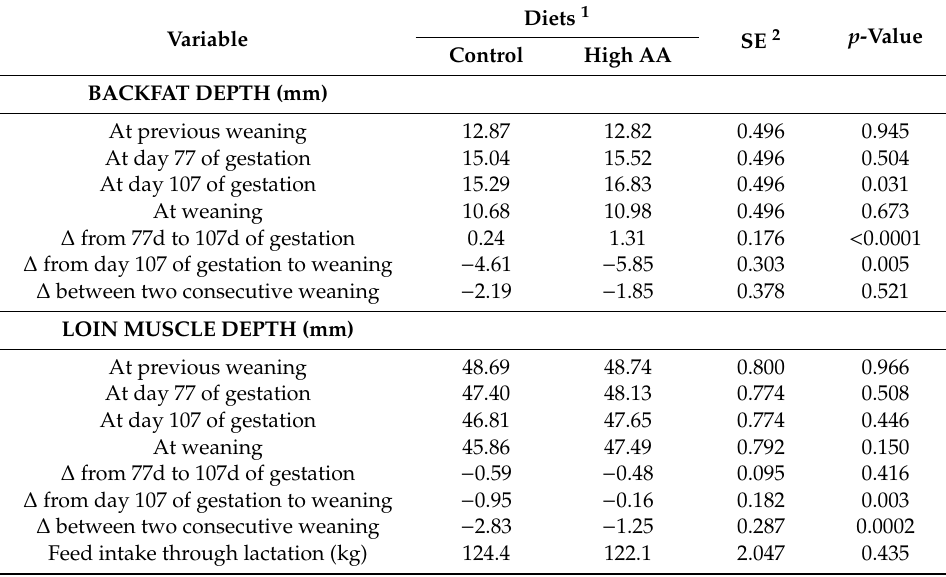
Table 2. E ff ect of dietary amino acid (AA) concentration from day 77 to 107 of gestation on backfat depth and loin muscle depth in hyperprolific multiparous sows.